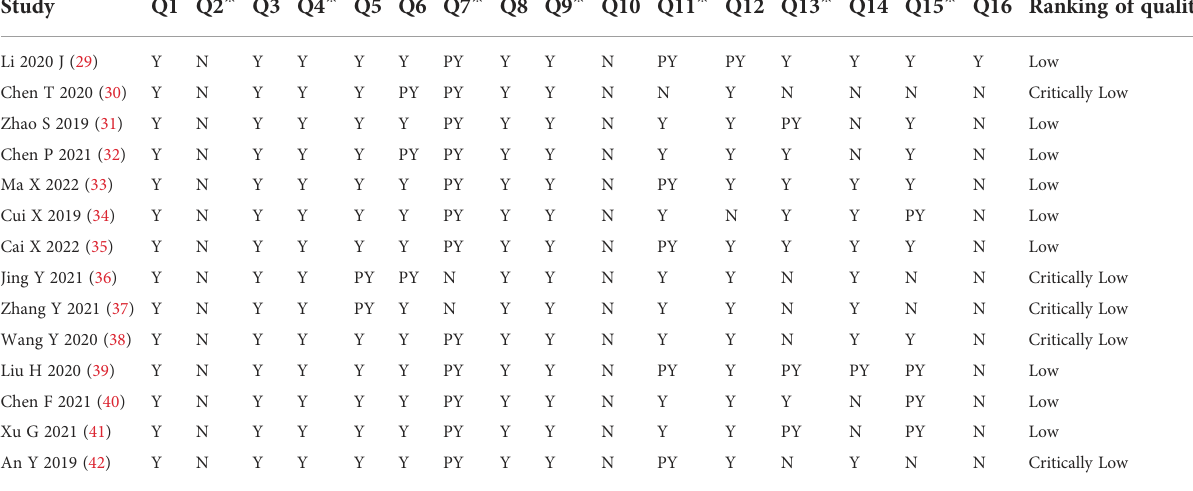
TABLE 2 AMSTAR scoring results of the included systematic reviews or meta-analysis. Study